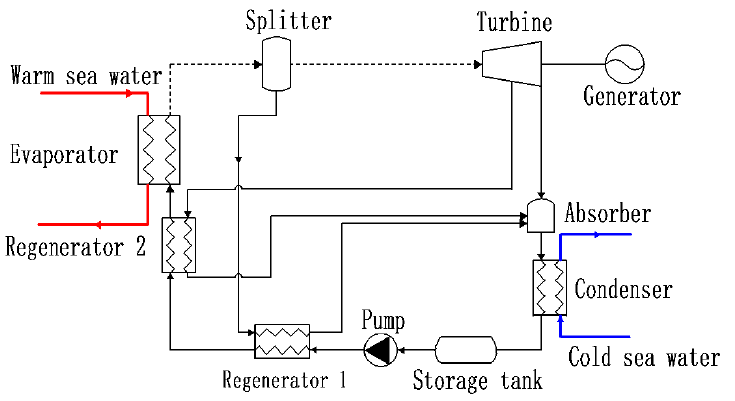
Figure 1. National Sea Cycle.